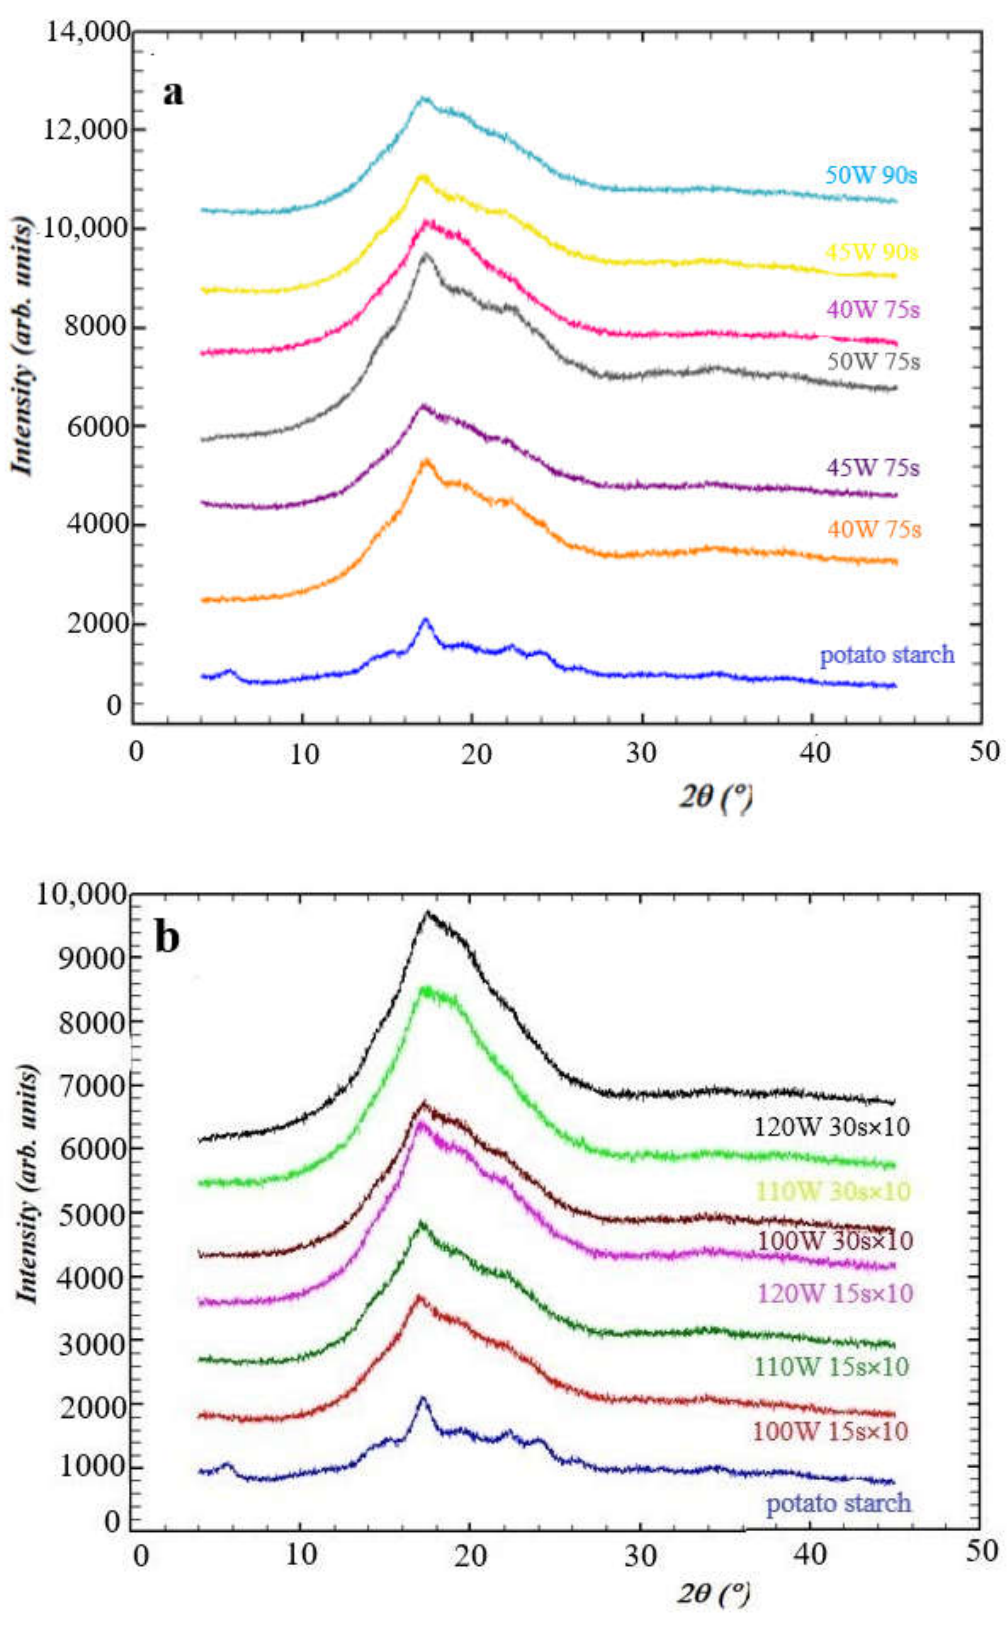
Figure 6. X-ray diffraction patterns of dextrins obtained after heating potato starch under continuous ( a ) and discontinuous ( b ) microwave irradiation.